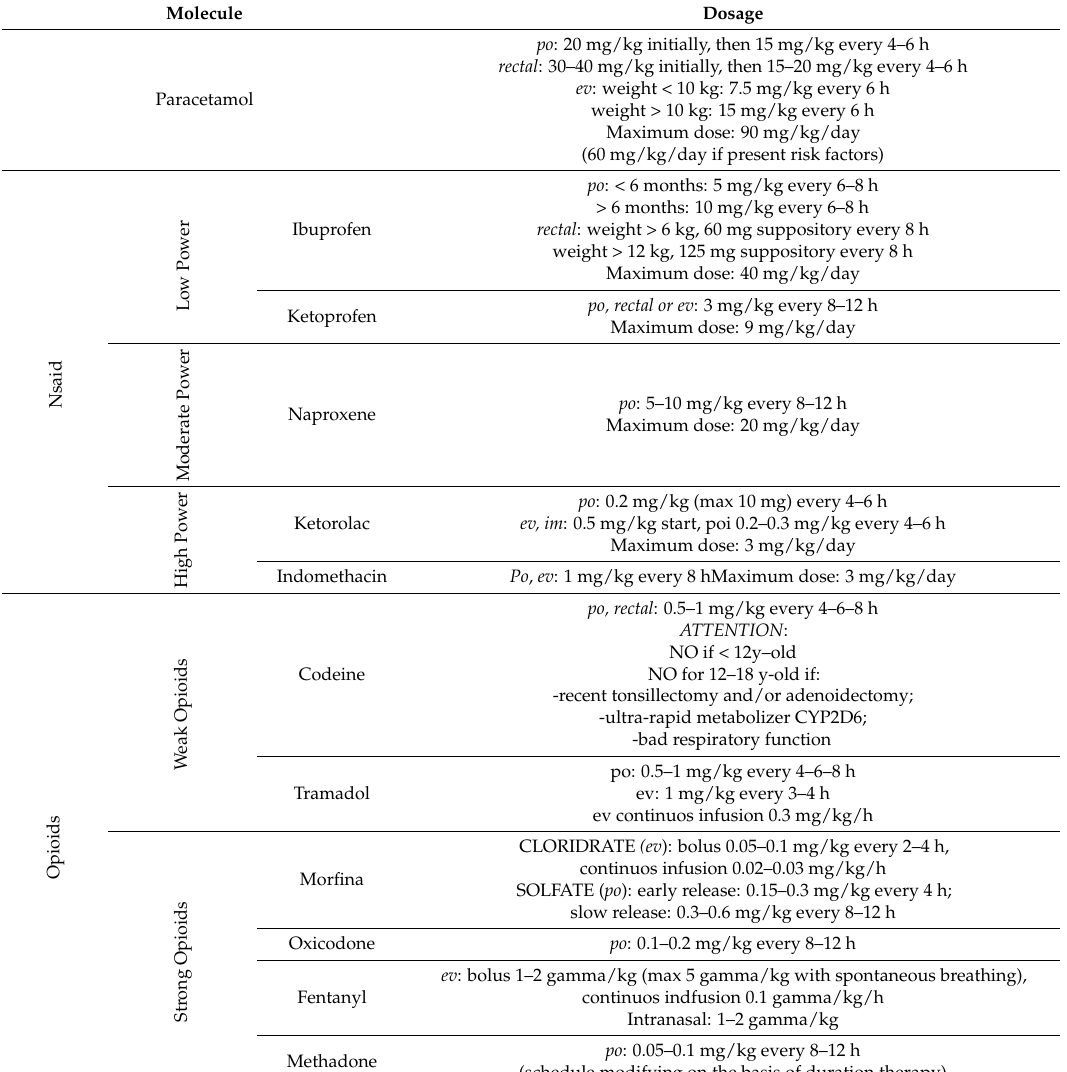
Table 2. Paracetamol, nonsteroidal anti-inflammatory drug (NSAIDs), and opioids dosage. Molecule Dosage